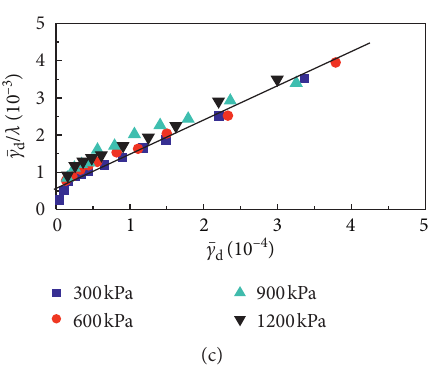
Figure 13: Relation between c 0.00.10.20.30.40.5